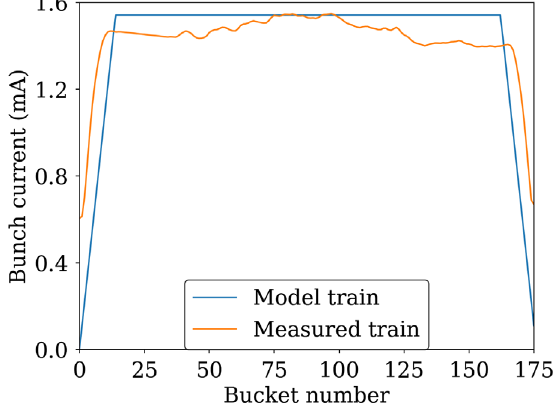
FIG. 2. Comparison of the predicted beam transient for differ- ent train current profiles with measured bunch time